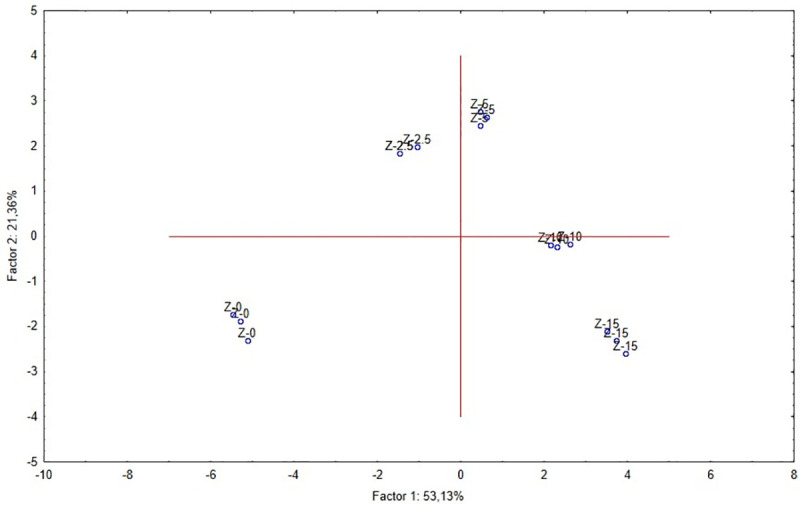
Projection of the variables of the factor plane.The correlation matrix is singular, so the generalized reciprocal method is used.